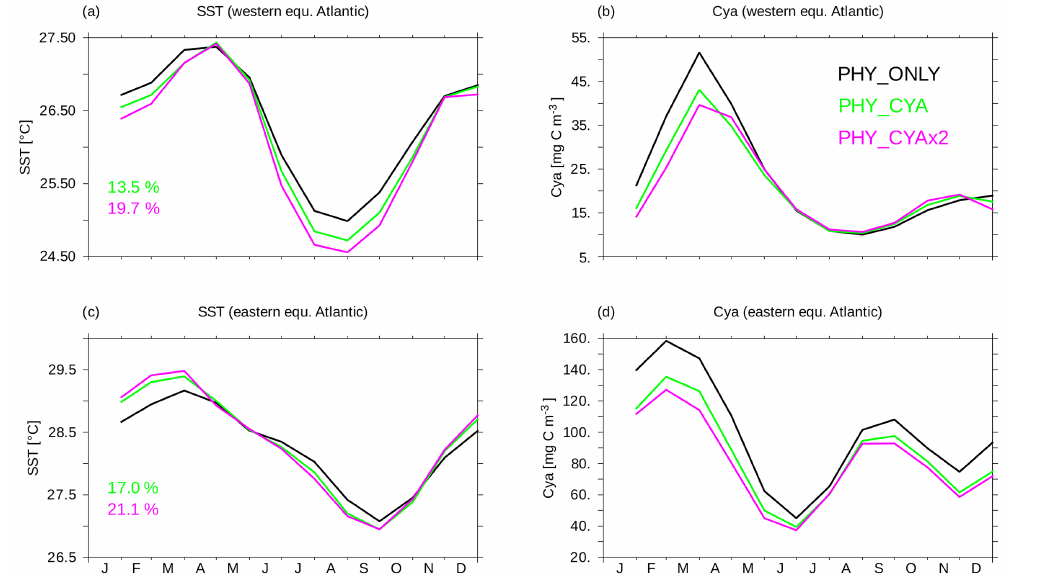
Figure 9. (a, c) Climatological monthly mean seasonal cycle of SST ( ◦ C) in the western (a, b) and eastern (c, d) tropical Atlantic in PHY_ONLY (black), PHY_CYA (green), and PHY_CYAx2 (purple). The displayed numbers show the change in the amplitude in percentage. (b, d) Climatological mean seasonal cycle of surface cyanobacteria concentrations (mgCm − 3 ) in the western (a, b) and eastern (c, d) tropical Atlantic in PHY_ONLY (black), PHY_CYA (green), and PHY_CYAx2 (purple). The locations are shown as black boxes in Fig.